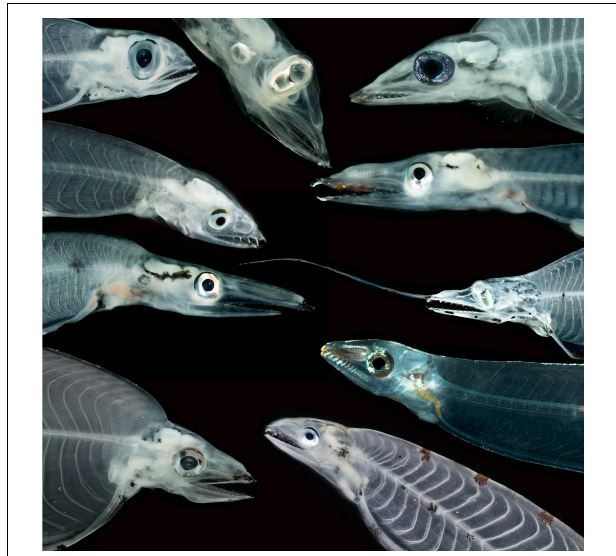
FIGURE 2 | A sample of morphological diversity in the heads of leptocephalus larvae, showing differences in shape, dentition, pigmentation, eye shape, and rostral projections. Clockwise from top center: halosaurid “Tiluropsis,” nettastomatid Nettenchelys pygnaea , nettastomatid Facciolella sp. C FWNA, synaphobranchid Ilyophinae sp. D 3 FWNA from Straits of Florida, nettastomatid Saurenchelys stylura from Straits of Florida, ophichthid Stictorhinus potamius , congrid Xenomystax congroides , nettastomatid Facciolella sp., ophichthid Ophichthus puncticeps from Straits of Florida, and congrid Bathycongrus sp. A FWNA. All photos by Dante Fenolio.